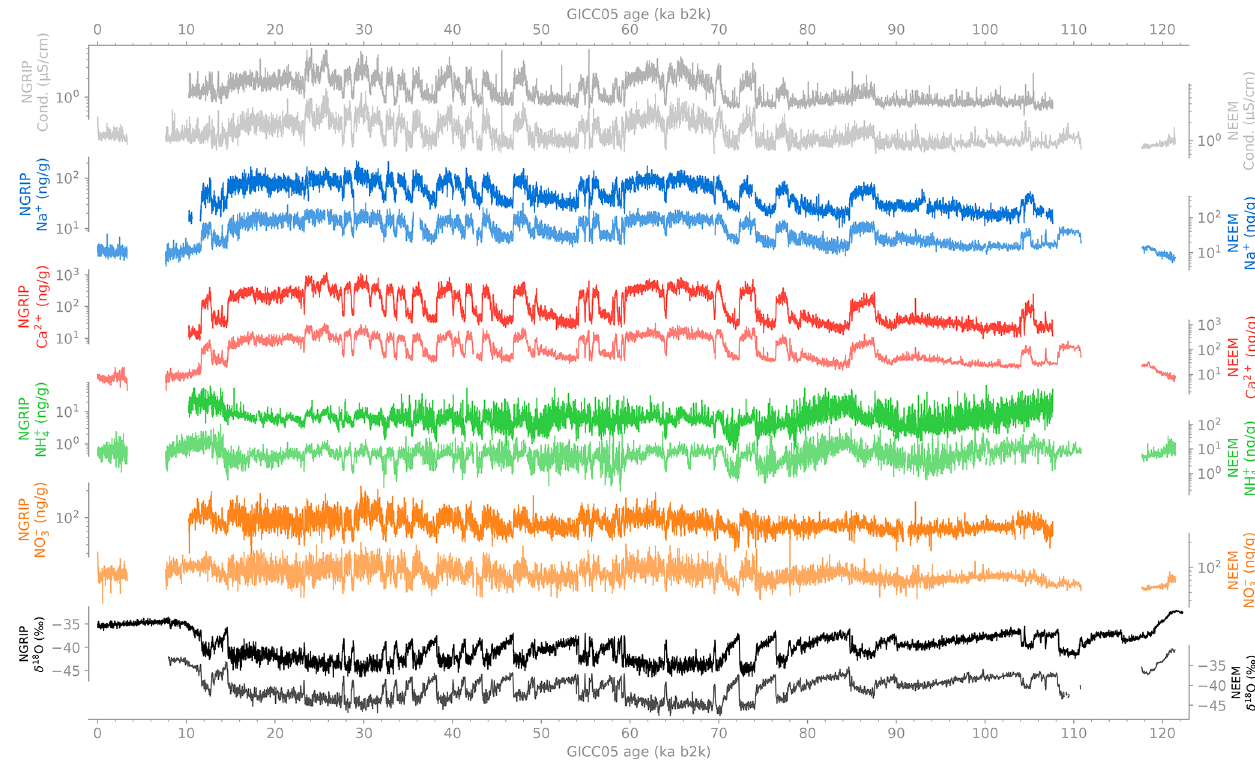
Figure 1. All aerosol time series as 10-year averages on the GICC05 timescale. Data from the NGRIP core are shown in darker colors with scales on the left-hand side, data from the NEEM core in lighter colors and scales on the right-hand side. The two large gaps in the NEEM data are from the brittle zone between 3.3 and 7.6kyrb2k and due to the over-folding at the bottom of the ice core from 110–114kyrb2k. The two lowermost panels show the NGRIP and NEEM water δ 18 O as 20- and 30-year averages (NGRIP project members, 2004; Gkinis et al., 2014,